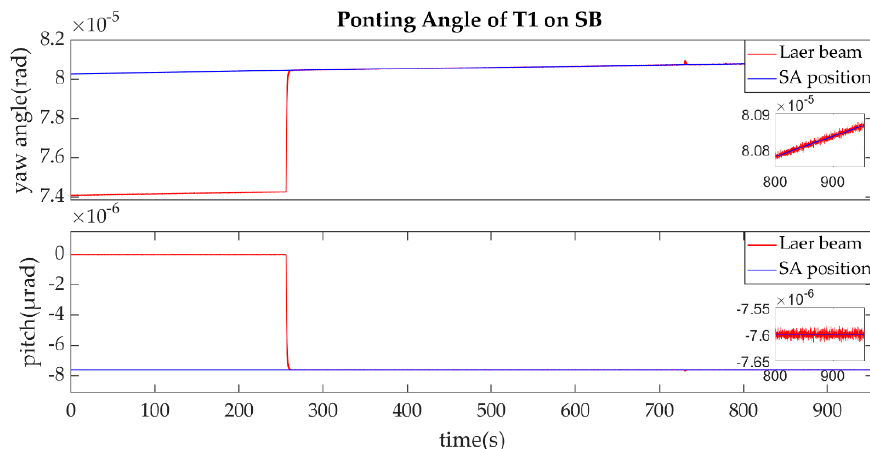
Figure 17. Ponting Angle of T1 on SB.